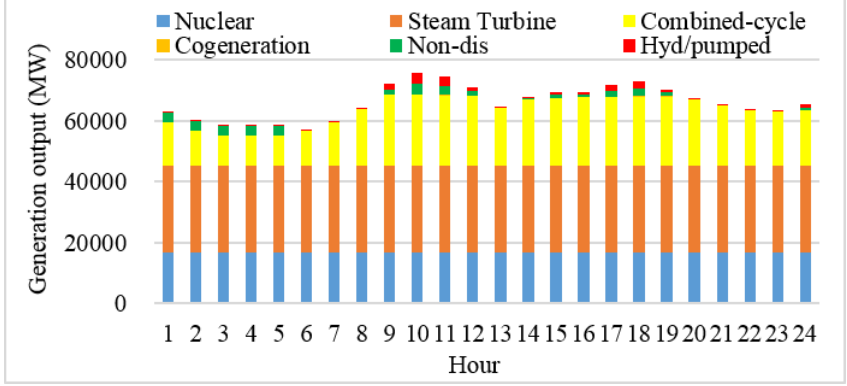
Figure 1. The calculated generation schedule for the peak-load day in 2016.